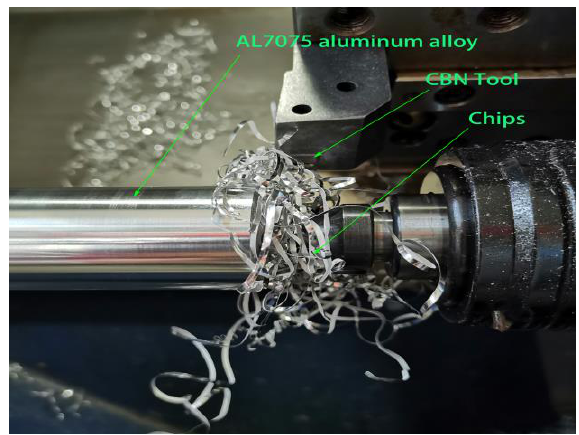
Figure 3. Chip winding.